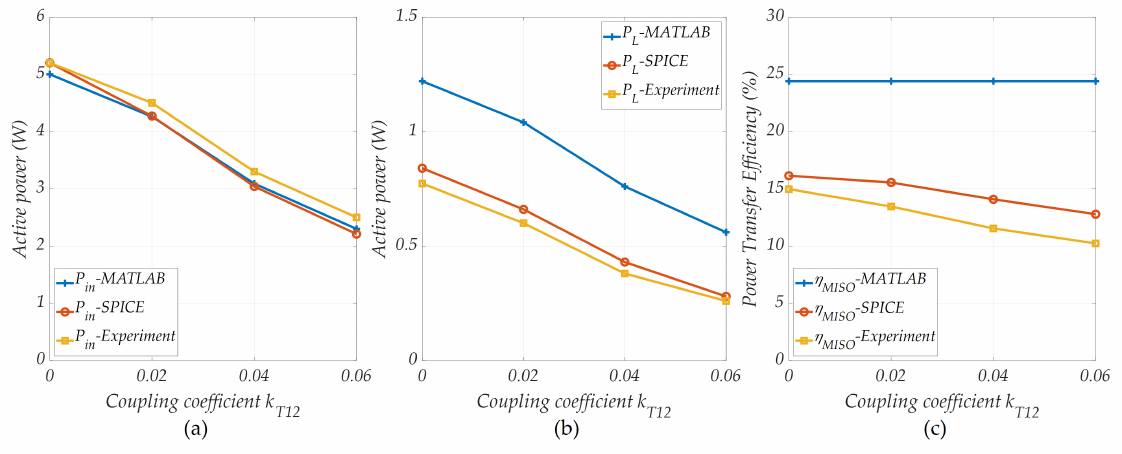
# » V bf : ( a ) P in , ( b ) P L , and ( c ) η MISO T